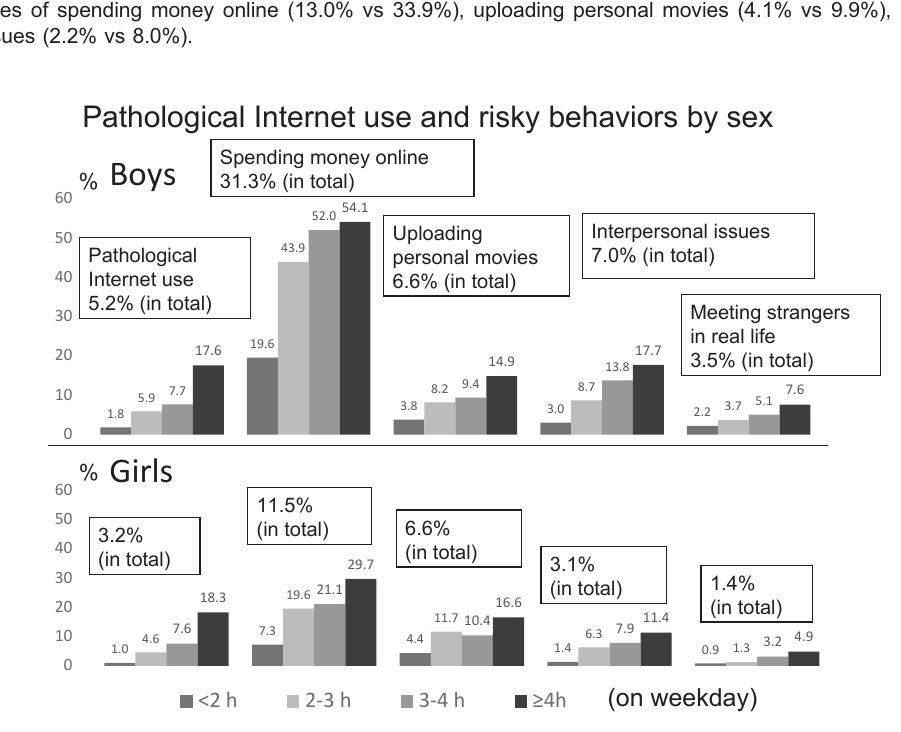
signi fi cantly associated. Comparing the di ff erences between boys and girls, higher PRs were seen with infrequent physical activity in boys and with no close friends in girls.